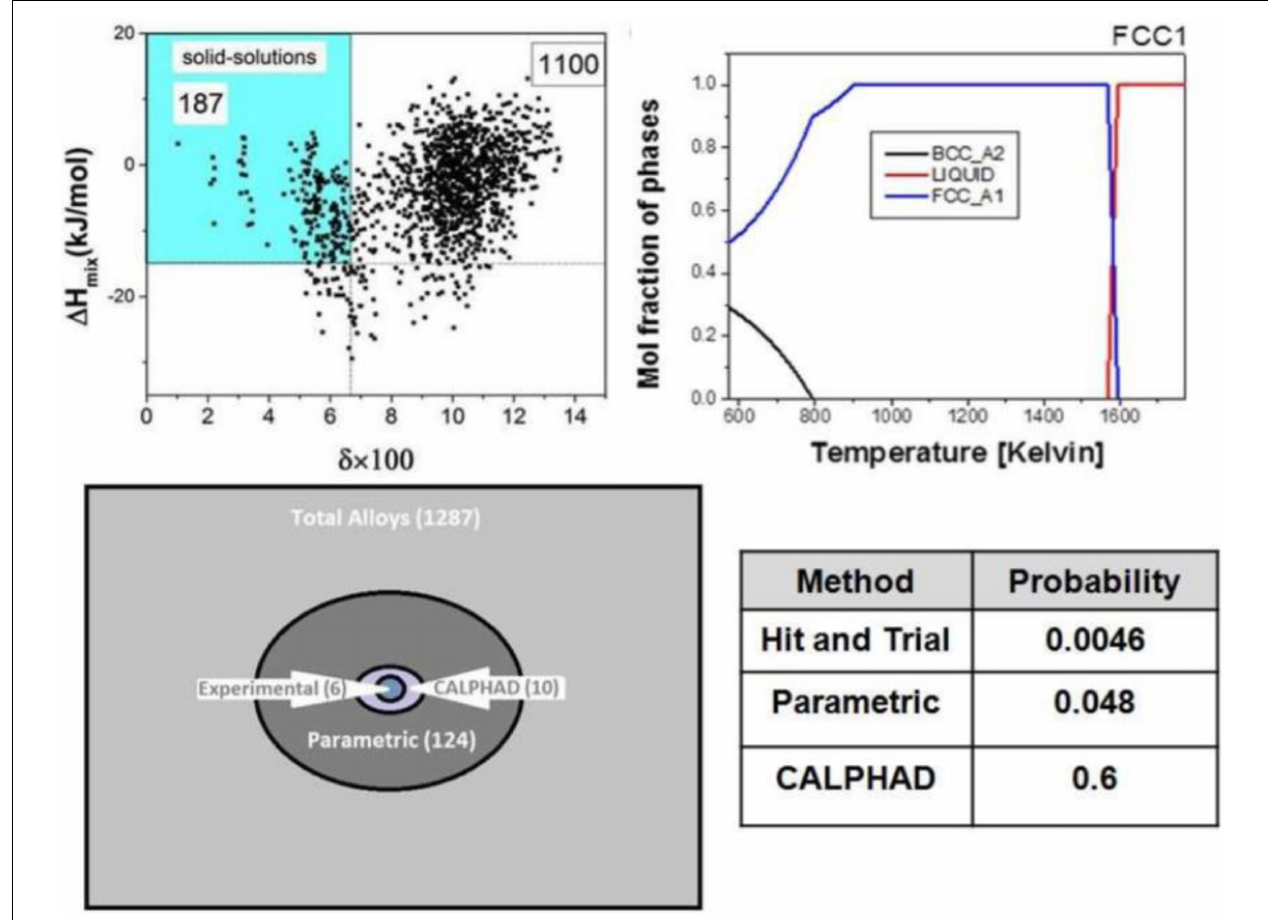
FIGURE 3 | Thermodynamic serendipity in designing single-phase HEAs (Takeuchi et al.,